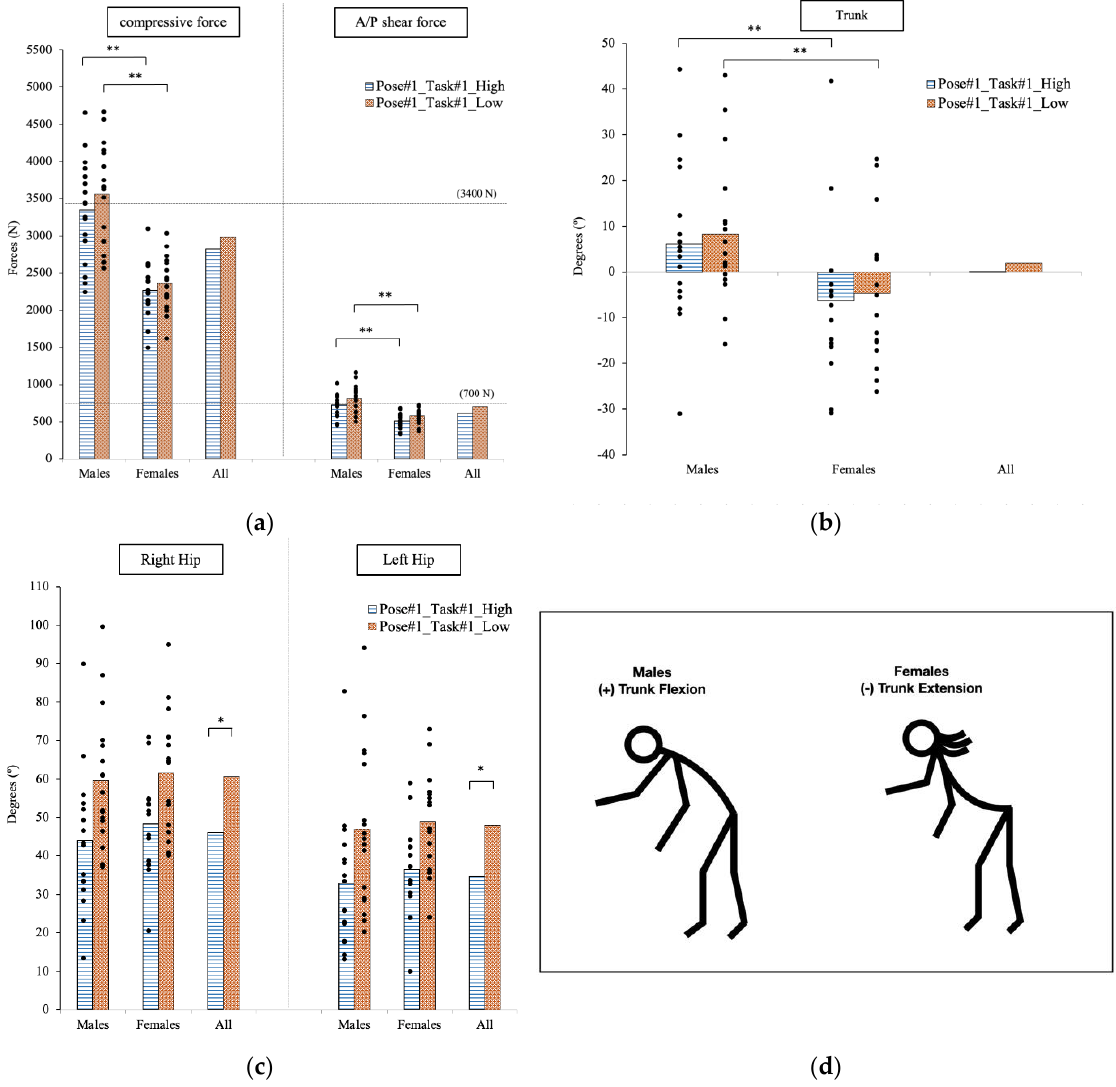
Figure 4. At Pose#1 in Task#1, the forces exposed on the lower back at two operational heights are plotted in ( a ). The trunk joint is plotted in ( b ). The hip joints are plotted in ( c ). Stick figures illustrating the significant difference in postures for males and females are shown in ( d ). * indicates a significant difference between two operational heights. ** indicates a significant difference between